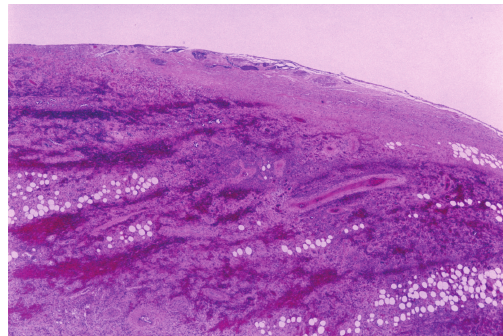
Figure 3: Histologic specimen of fibrolipoma on H&E stain. A variable amount of adipose tissue with a fibrovascular stroma covered by normal squamous